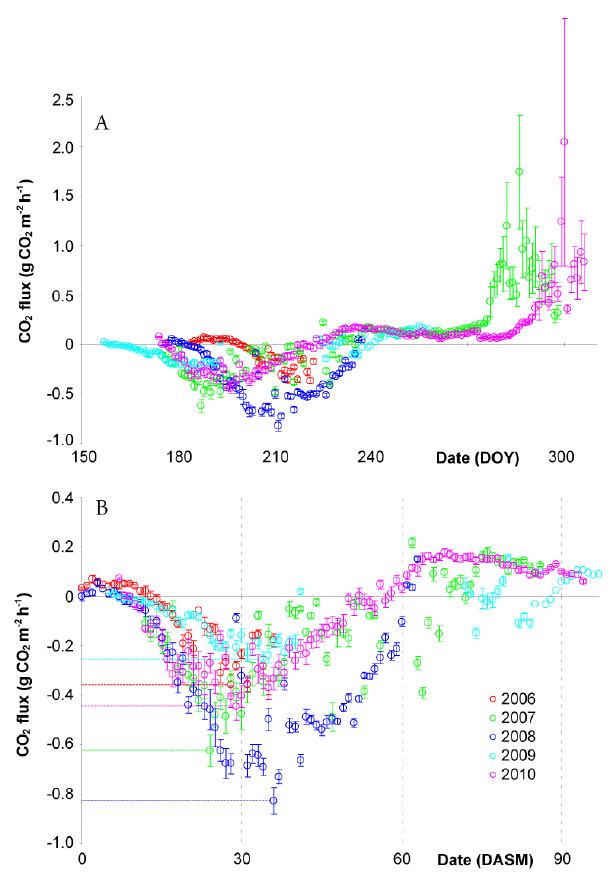
Fig. 5. CO 2 flux dynamics. A all measured fluxes, normalized to day of year (DOY); B growing season fluxes, normalized to day after snow melt (DASM). Each circle states the average between daily averaged hourly measurements of 6 or less individual chambers; error bars state the standard error between daily average values of individual